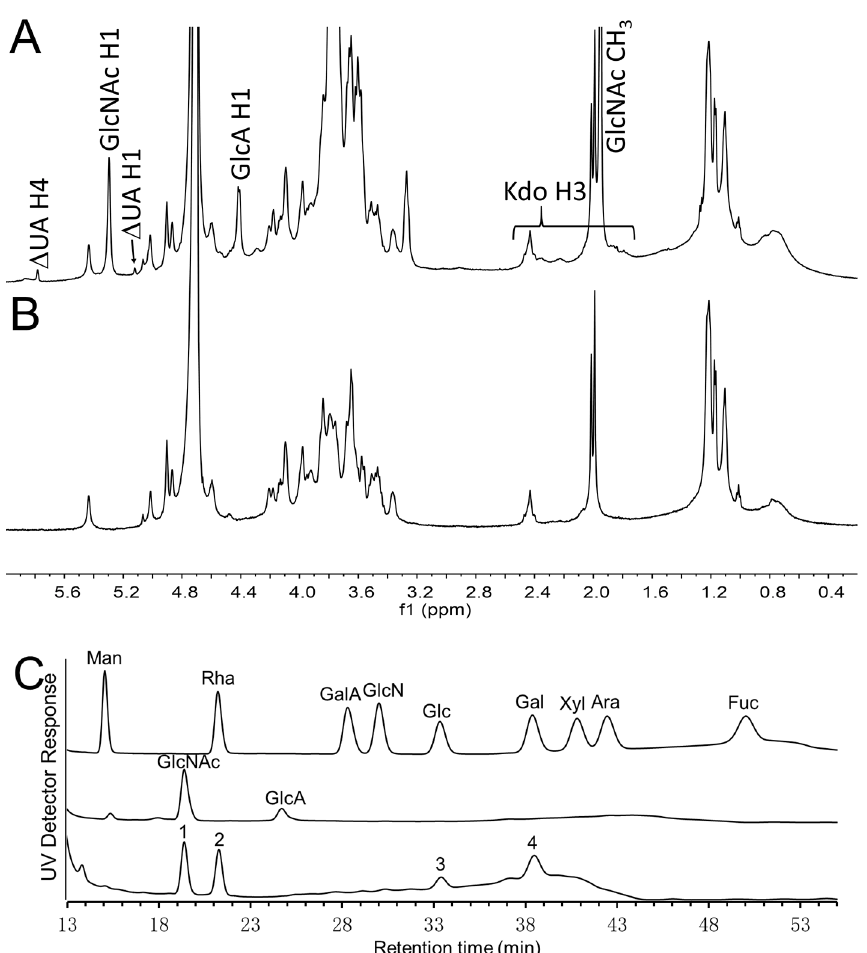
Figure 4. 1 H NMR spectrum of ( A ) resistant fraction 2 and ( B ) resistant fraction 2’. ( C ) Monosaccharide analysis of resistant fraction 2’. From top to bottom: nine kinds of monosaccharide standard, monosaccharide analysis of a heparosan tetrasccharide ( Δ UA-GlcNAc-GlcA-GlcNAc), and monosaccharide analysis of resistant fraction 2’.